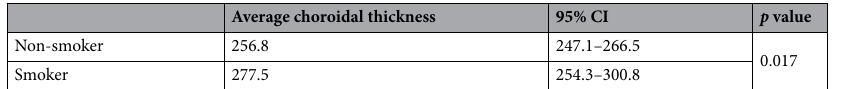
Table 3. Age, sex, and axial length adjusted average choroidal thickness. CI confidence interval.